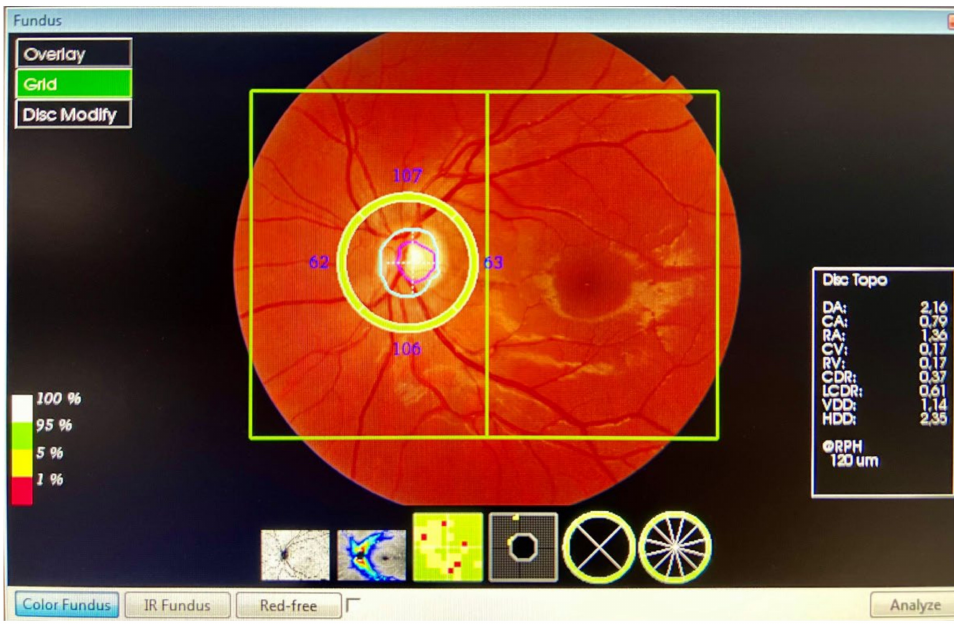
Figure 2. The 3D Wide Report